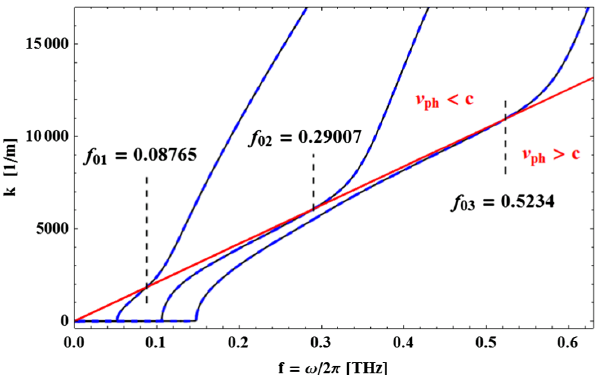
FIG. 4. Overlapping dispersion curves of the first three TM modes of a metal-dielectric waveguide for a lossless ε 00 1 ¼ 0 (blue, dashed line) and low-loss ε 00 1 ¼ 0 . 5 (black, solid line)